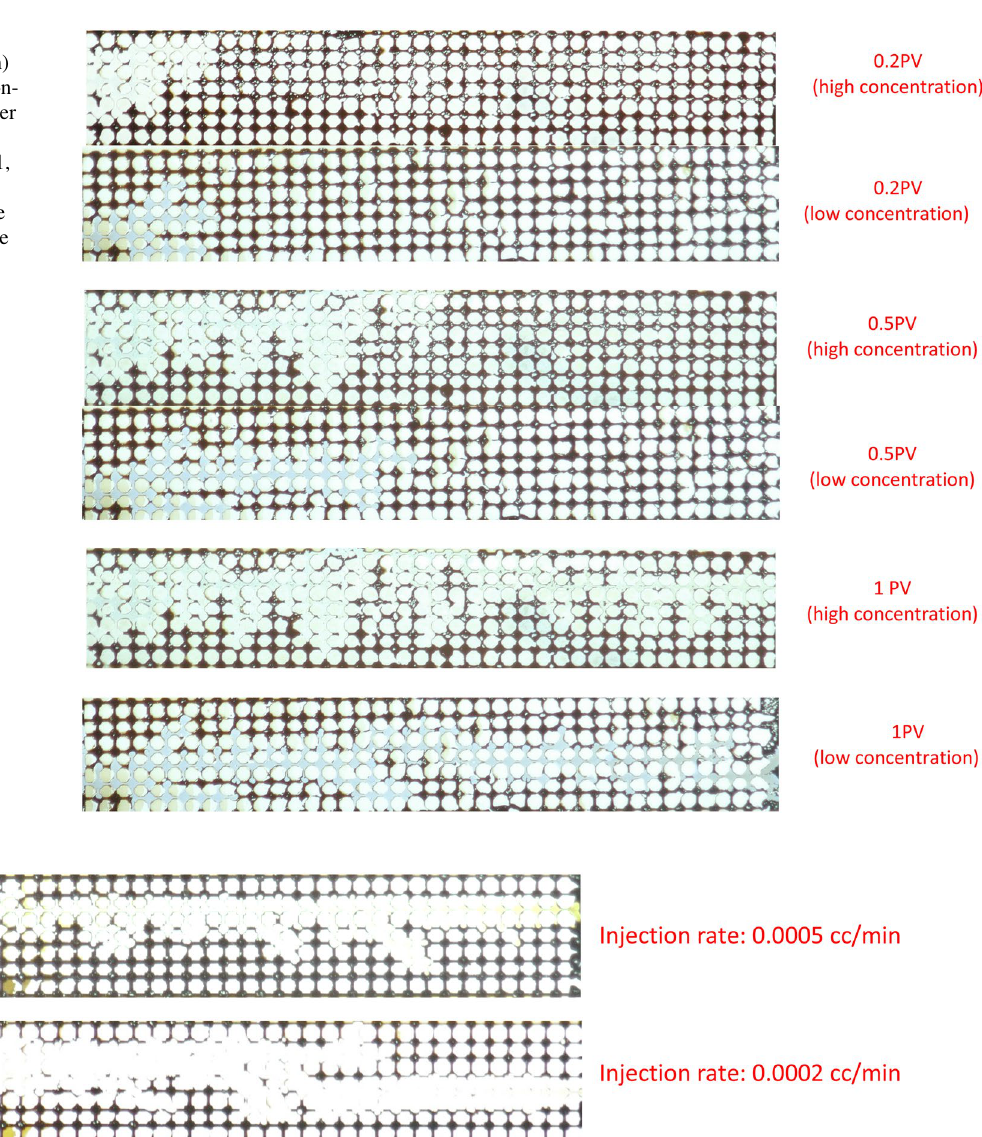
Fig. 6 Front stability for low-concentration (1000 ppm) polymer solution and high-con- centration (2250 ppm) polymer solution at pore volumes of 0.2, 0.5 and 1, polymer type 1, injection rate; 0.0002 cc/min, injection point on the left side (brown color: oil, whitish blue